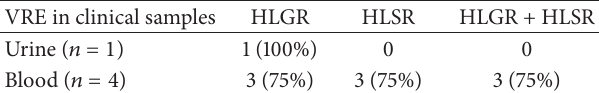
Table 5: Prevalence of HLAR in